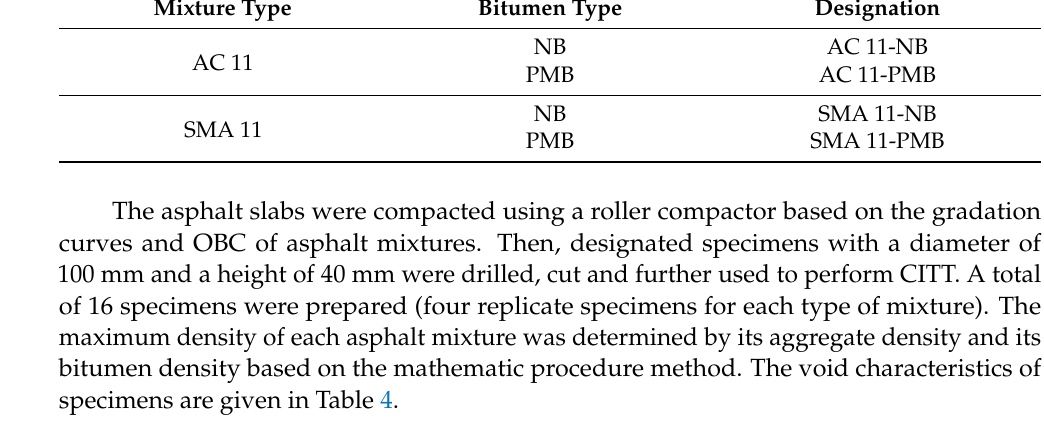
Figure 1. Gradation curves of ( a ) AC 11 and ( b ) SMA 11. Table 3. Designation of the tested specimens according to selected mixture types and bitumen types.